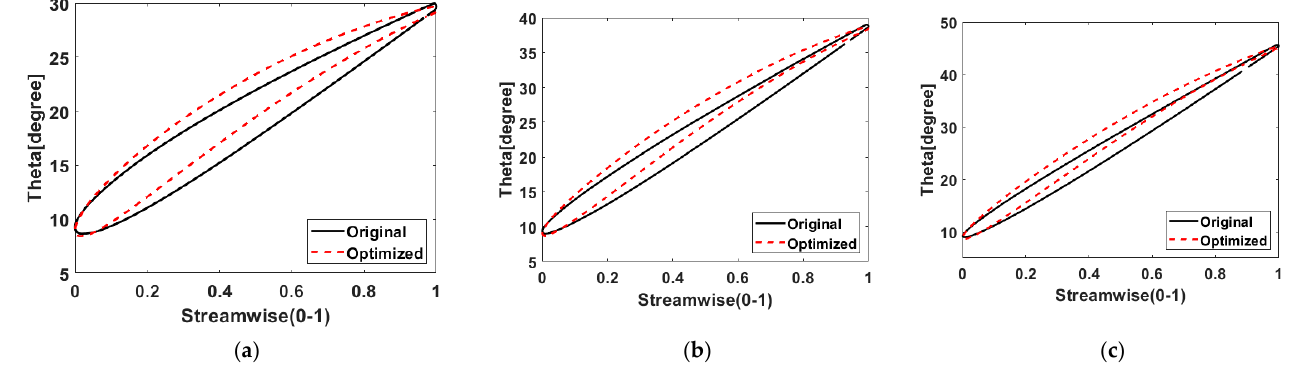
Figure 8. Initial and optimized blade profiles at different spans: ( a ), ( b ) and ( c ) are the blade profiles at 20%, 50% and 80% of the span layers before and after optimization, respectively.